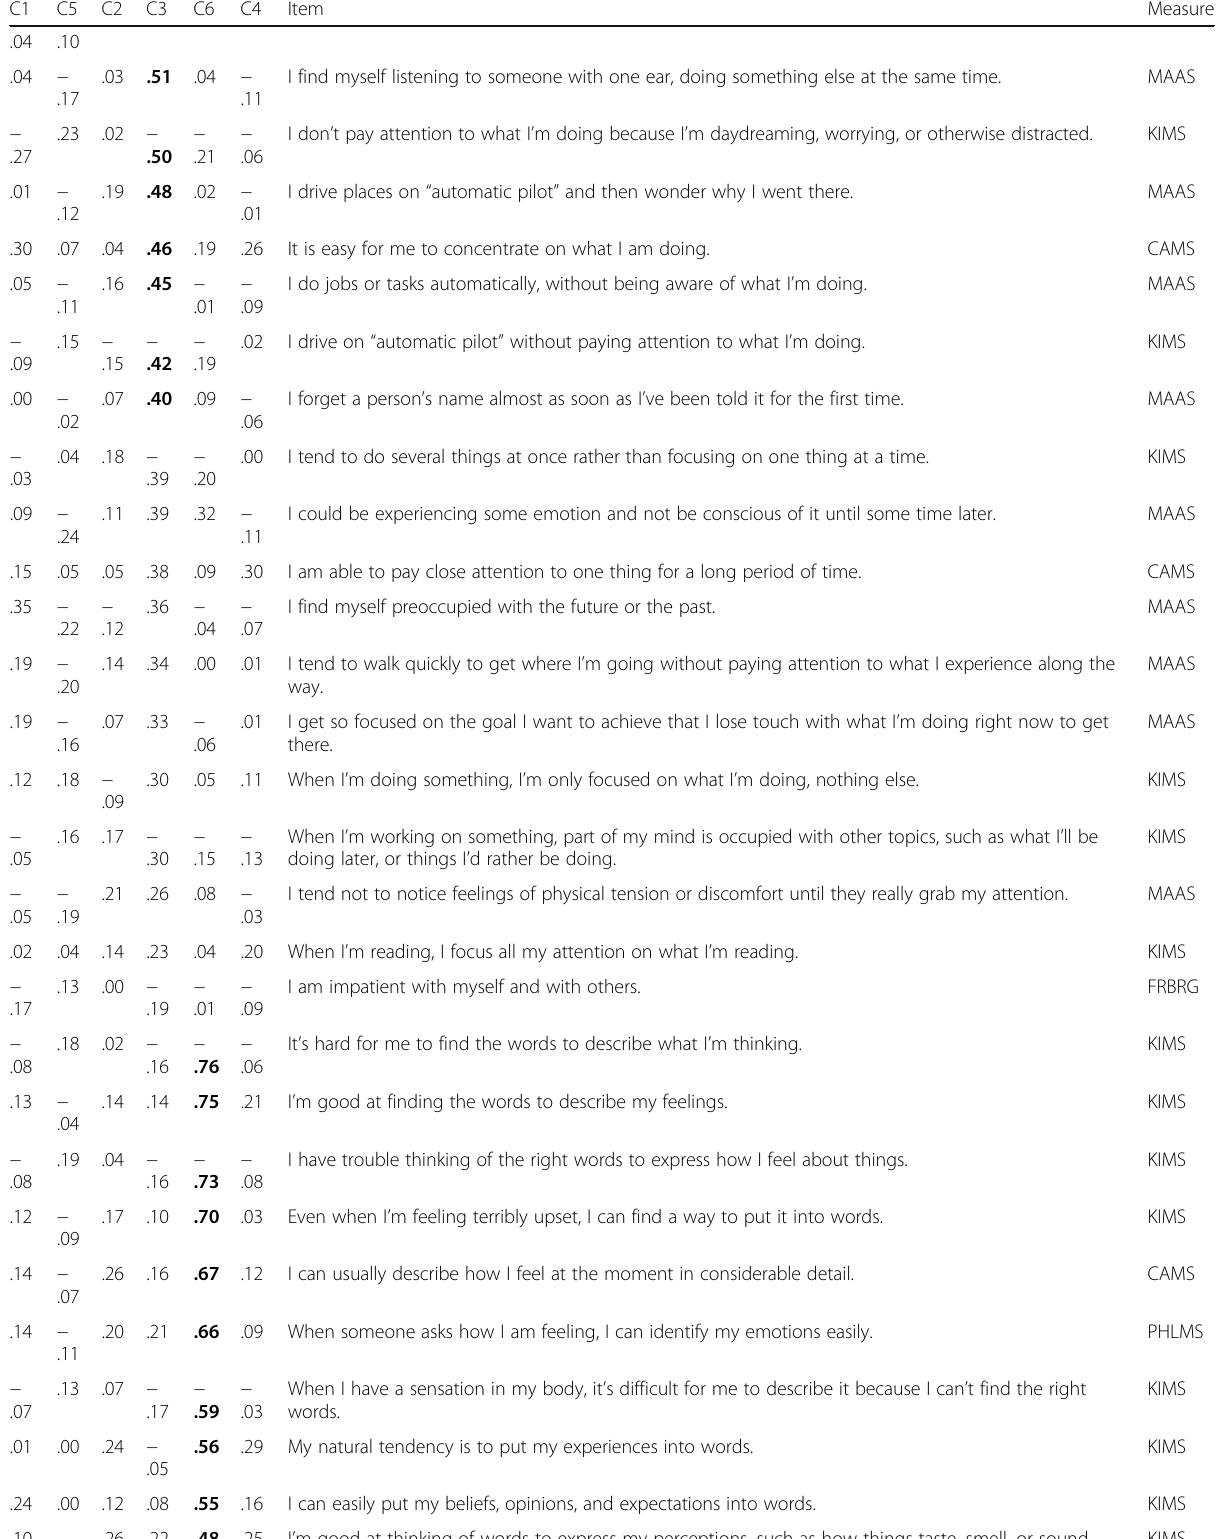
Table 4 Component loadings of the mindfulness items on the final six components (Continued) C1 C5 C2 C3 C6 C4 Item Measure .04